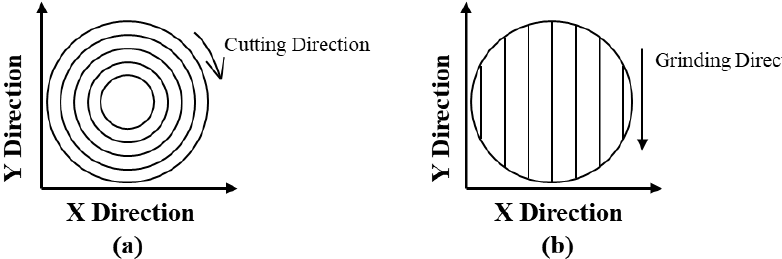
Figure 1. The contact angle measurement direction of the acquired image of the droplet profile on the different polished surface. The X direction is perpendicular, and the Y direction is parallel. ( a ) The texture is Ti-6Al-4V after CNC machine cutting and chemical polishing. ( b ) The texture is Ti-6Al-4V after mechanical polishing.